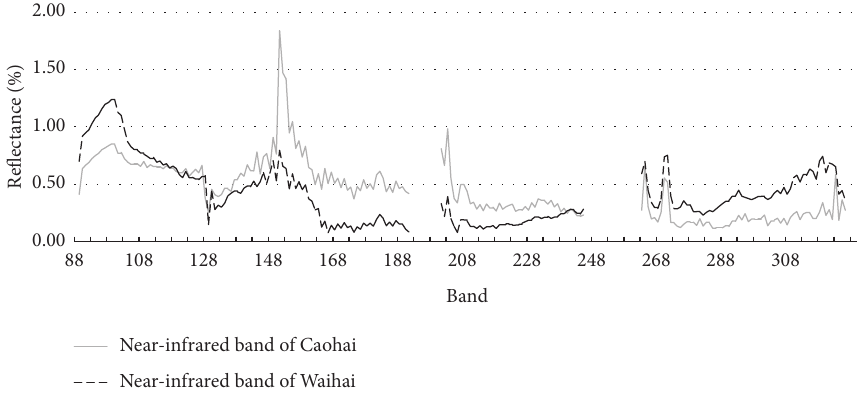
Figure 5: Spectral reflectance curves of Caohai and Waihai in the near-infrared band. Table 3: Characteristic bands of Caohai and Waihai in the near-infrared band. Area